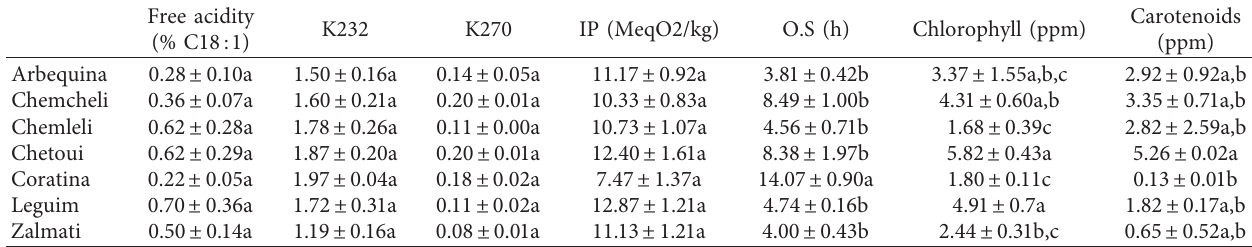
Table 2: Quality indices, oxidative stability, and pigment contents of the seven VOOs. Free